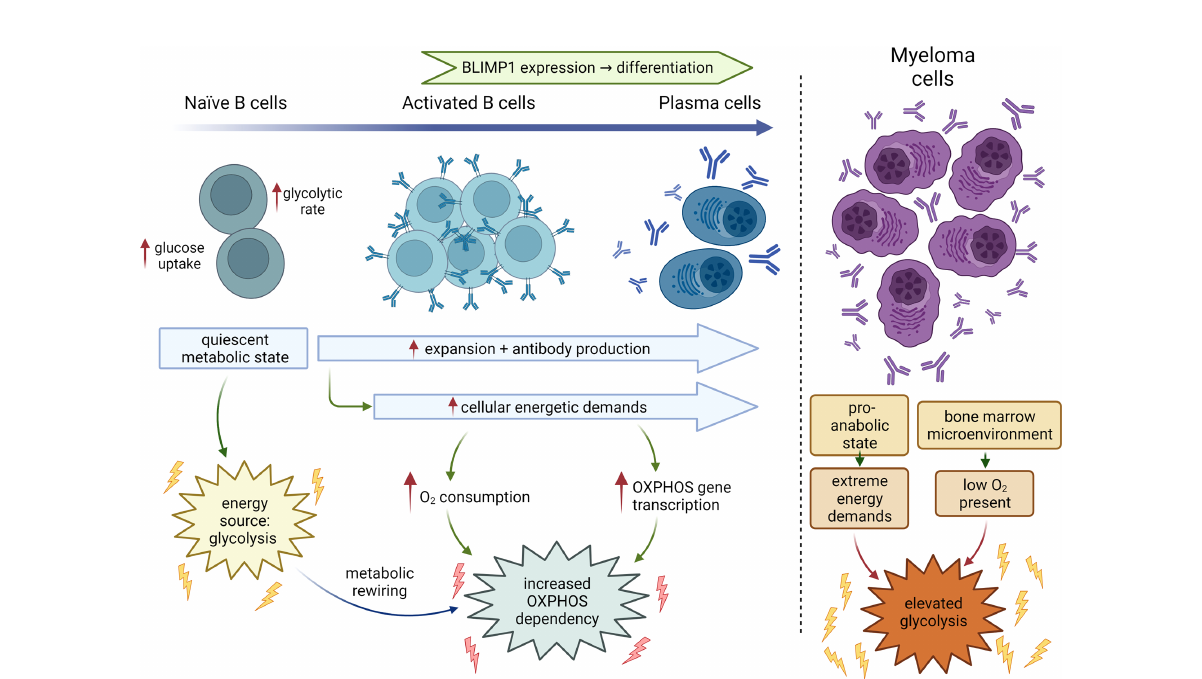
FIGURE 1 Metabolic changes during B-cell differentiation. Metabolic states of naïve B cells, activated B cells, fully differentiated plasma cells and MM cells. Normal B-cells transition from a primary dependency on glycolysis to additionally relying on elevated oxidative phosphorylation during development and differentiation. Myeloma cells continue to rely on glycolysis driven in part by the hypoxic conditions in the bone marrow, increased bioenergetic demands to sustain rapid growth and proliferation with OXPHOS likely supporting cellular functions like antibody production. BLIMP1, B lymphocyte-induced maturation protein